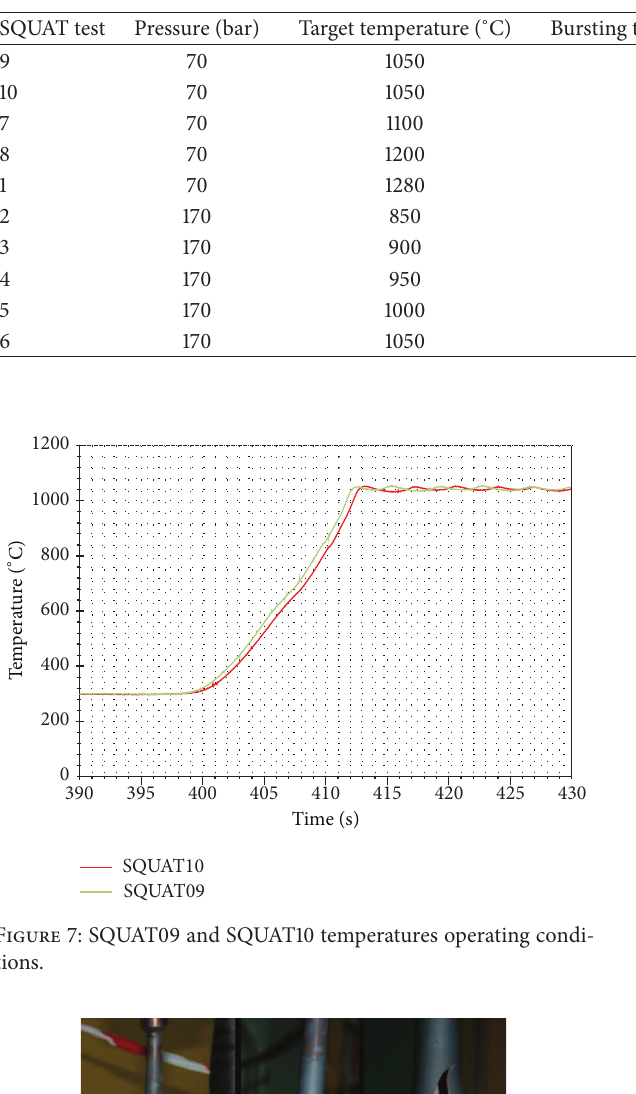
Table 3: Experimental results of SQUAT tests.